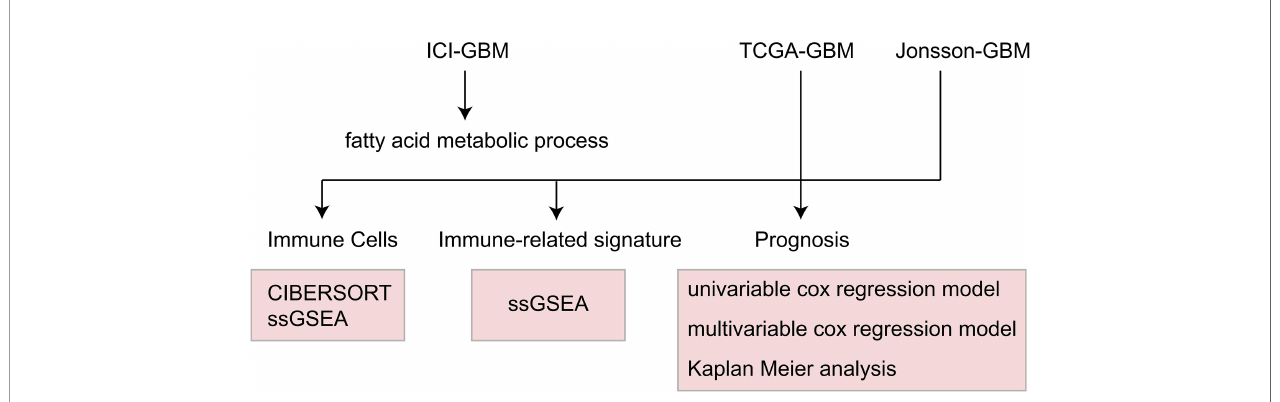
FIGURE 1 | An overview of this